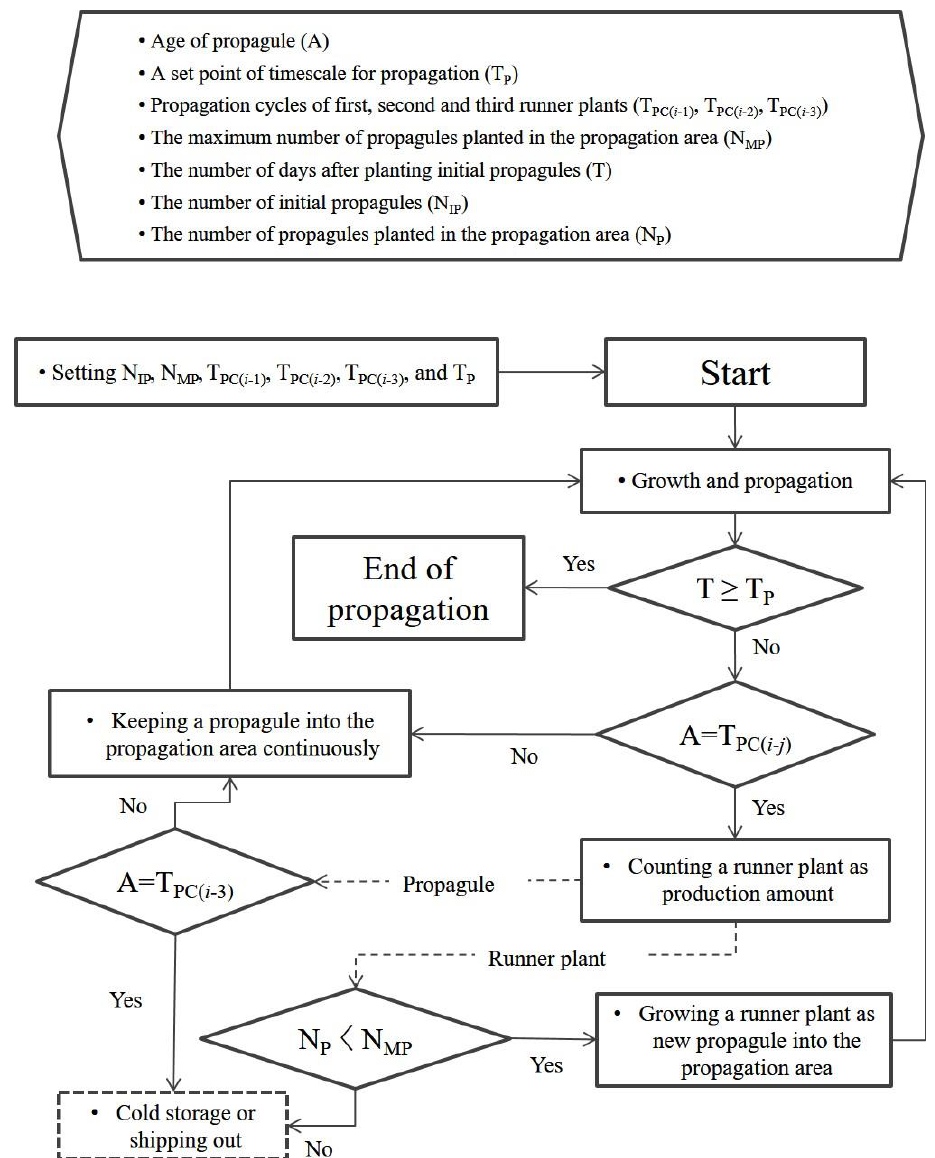
Figure 2. A flow chart of a program to predict the production of strawberry transplants for the autotrophic transplant production method. autotrophic transplant production